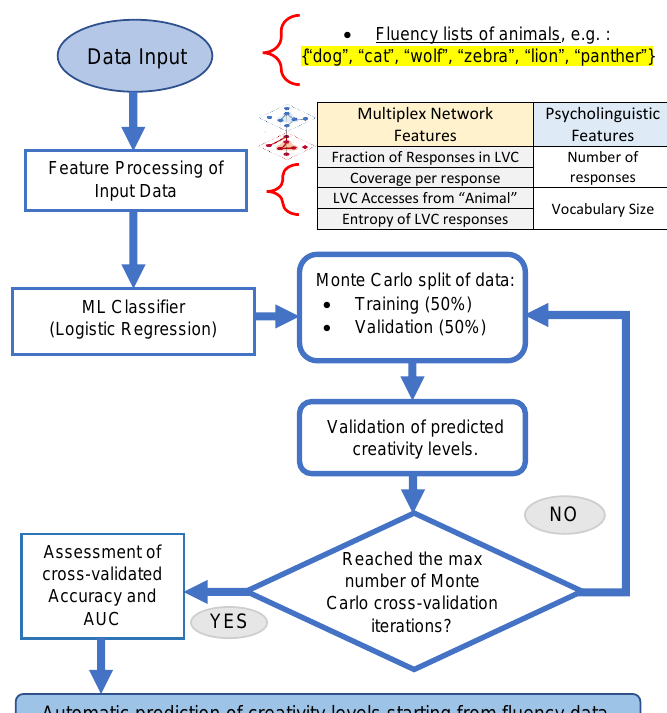
Figure 2. Flowchart of the adopted methodology, starting from fluency lists and extracting network features from each of them. For every list, also psycholinguistic features are computed. Every list is then represented as a vector of network and psycholinguistic features. These vectors, representing the original cognitive data of high and low creativity people, is then used for training a machine learning classifier. The performance assessment of the classifier is cross-validated through a Monte Carlo procedure, i.e., averaging accuracy and AUC over 1000 random splits of data between test and validation